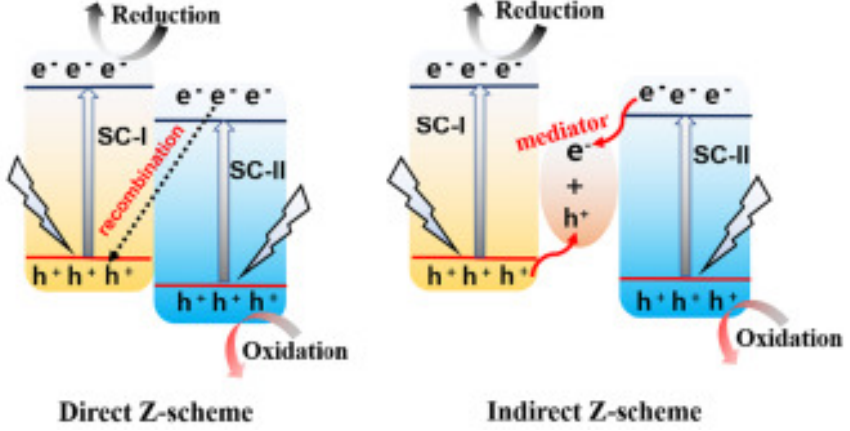
Figure 15. Direct and indirect types of Z-scheme composites. Adopted from [195] with the permis- sion of Elsevier. of